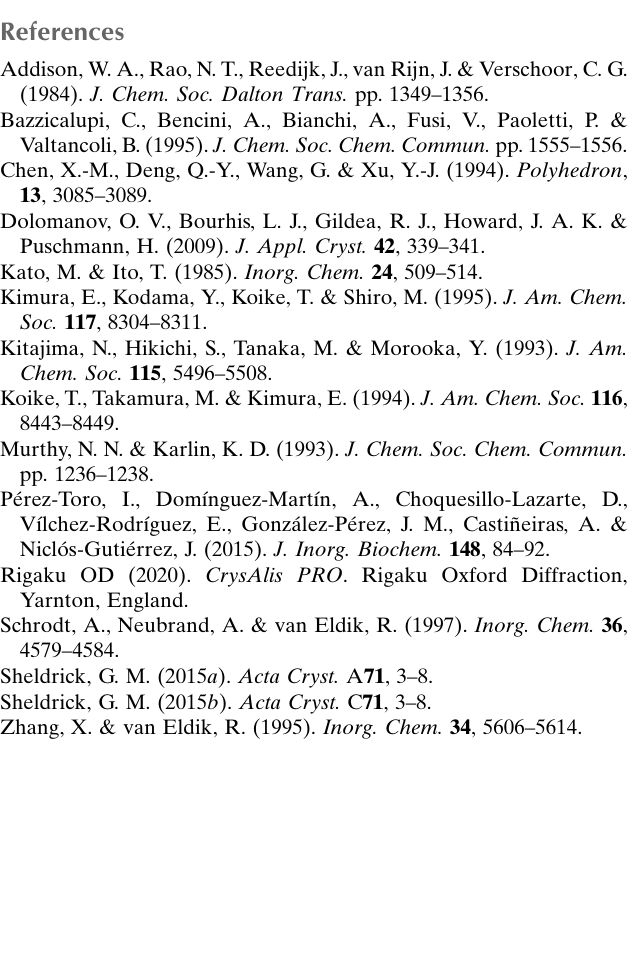
Table 2 Experimental details. Crystal data Chemical